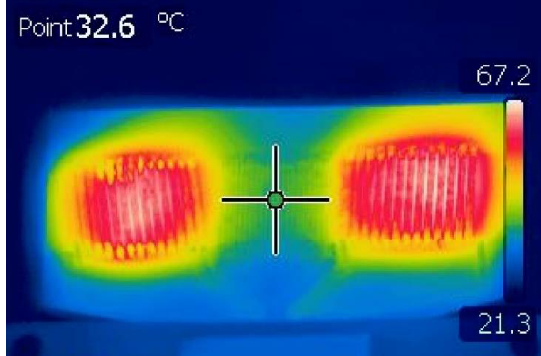
Figure 6. Temperature distribution of the sensor with 700 mA p-p excitation current at 100 kHz.